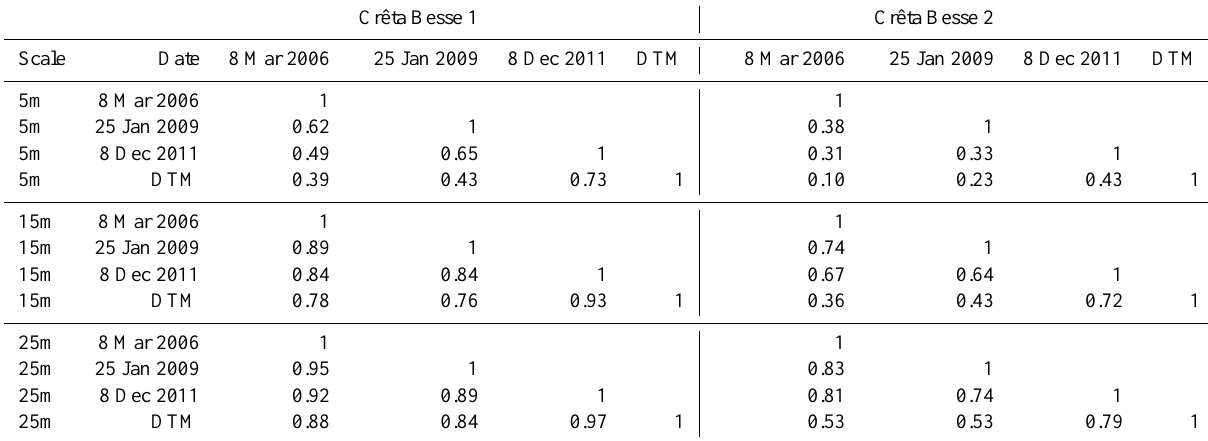
Table 7. Coefficient of determination ( R 2 ) of surface roughness correlations in the CB1 and CB2 basins ( p < 0.0001). Crêta Besse 1 Crêta Besse 2